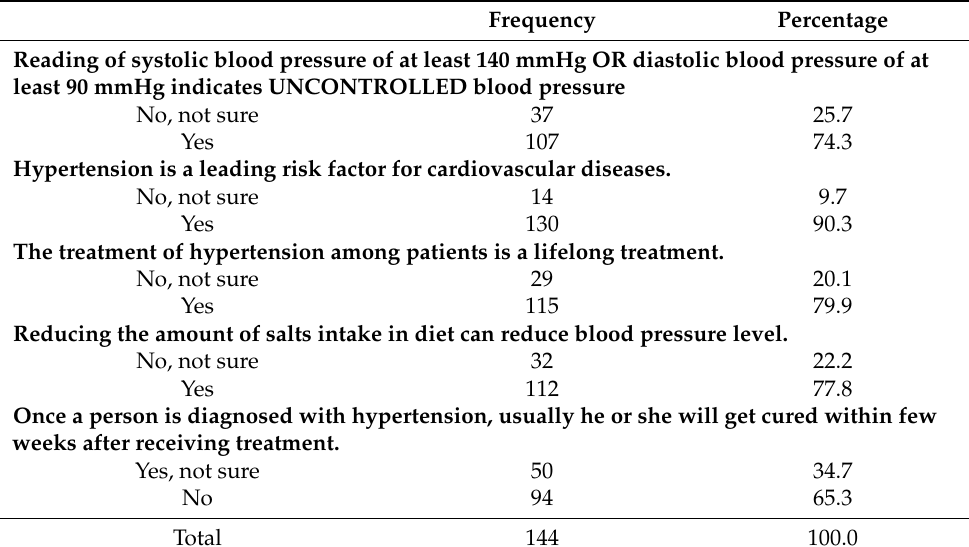
Table 2. Overall responses to health literacy